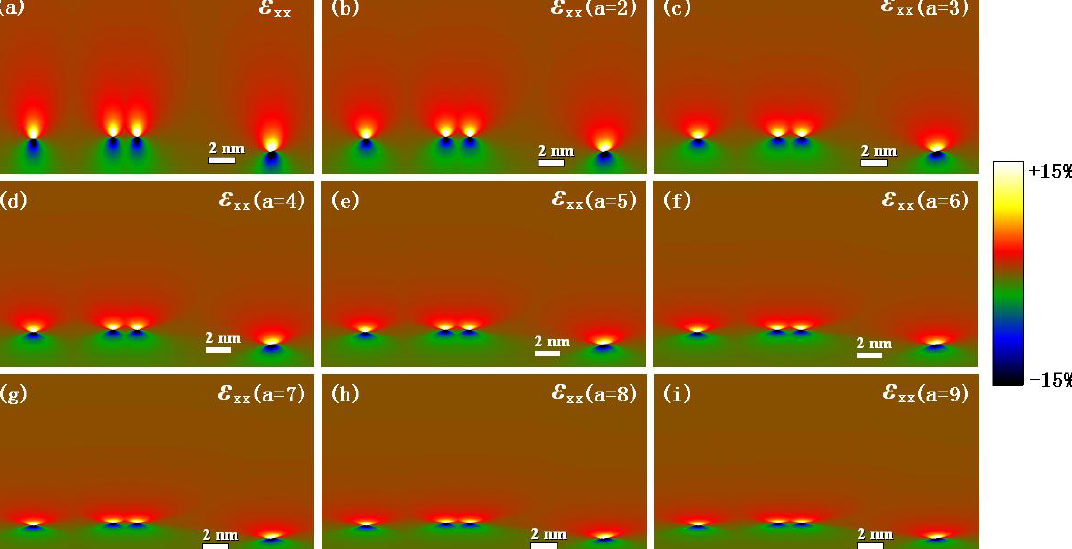
given by xx corresponding to different values of xx